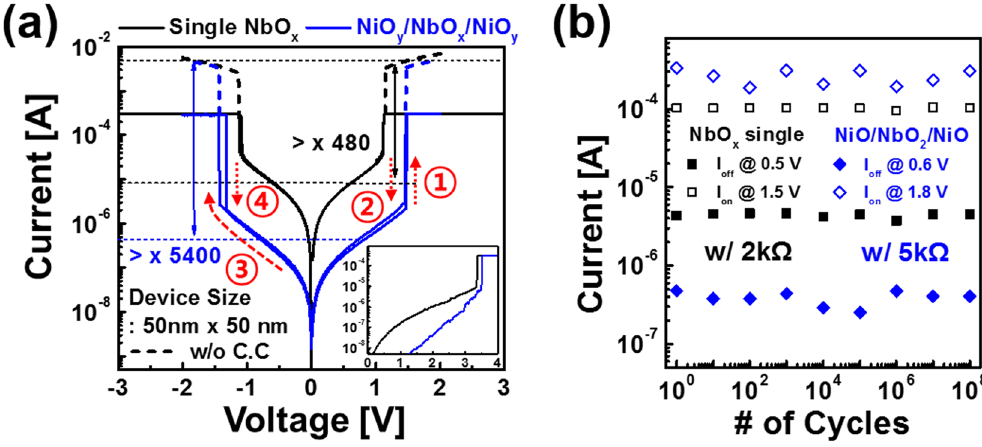
Figure 3. ( a ) DC I-V characteristics of NbO x single layer device and NiO y /NbO x /NiO y device during threshold switching after forming process (inset) and ( b ) AC endurance of both